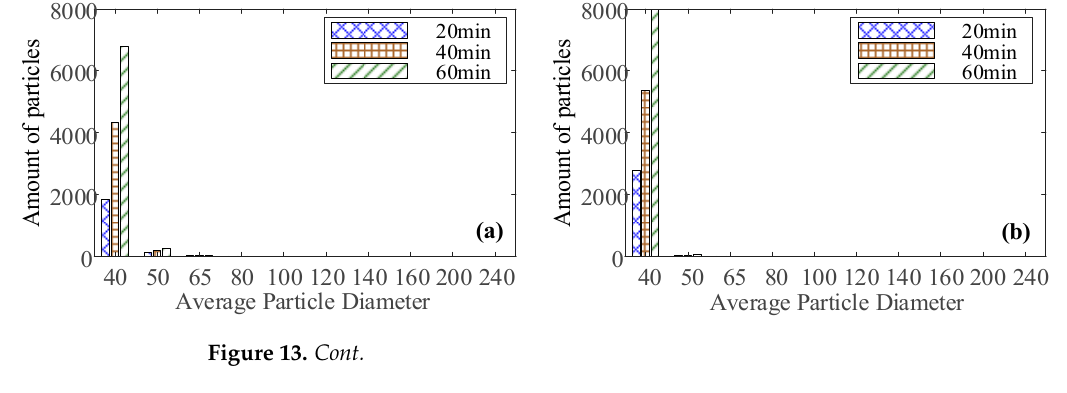
40 50 65 80 100 120 140 160 200 240 Average Particle Diameter